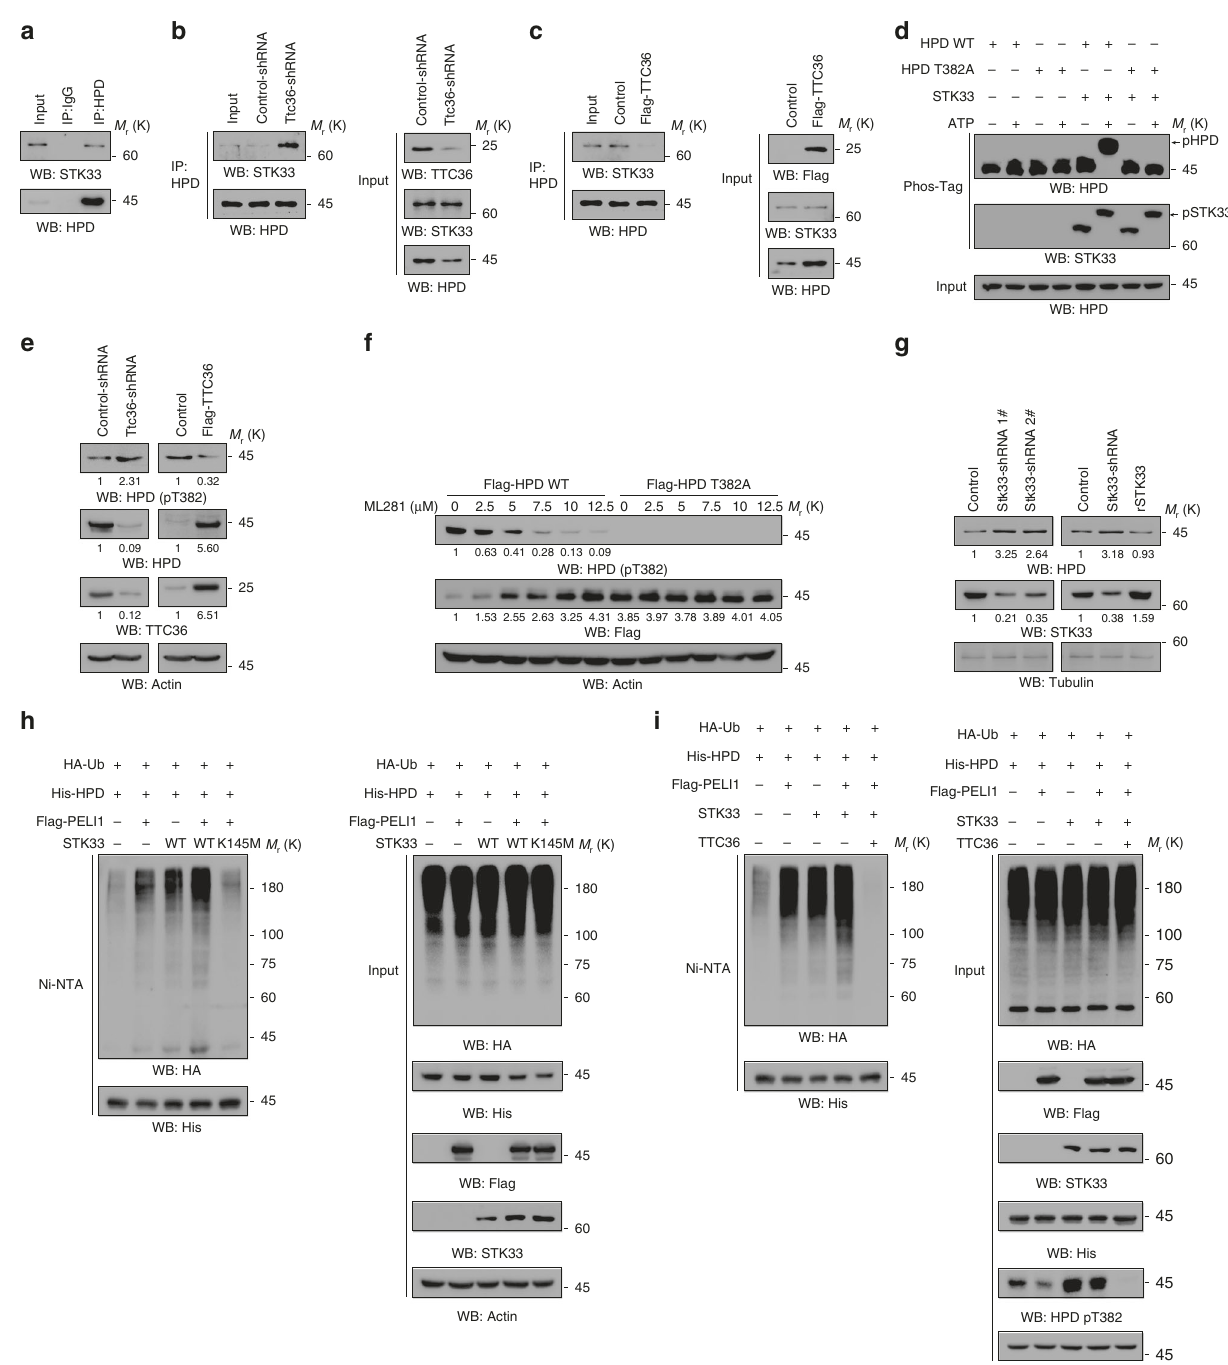
Fig. 4 TTC36 reduces the binding of STK33 to HPD and subsequent STK33-mediated HPD T382 phosphorylation. Immunoblotting analyses were performed with the indicated antibodies a – i . a Immunoprecipitation analyses of LO2 cell lysates were performed with an anti-HPD antibody. b , c Ttc36 shRNA b or Flag-TTC36 c were stably expressed in LO2 cells. Immunoprecipitation analyses with an anti-HPD antibody were performed. d Phos-tag analysis was performed with bacterially puri fi ed His-STK33 and His-HPD or His-HPD T382A mutant in the presence or absence of ATP. e Ttc36 shRNA#1 (left panel) or Flag-TTC36 (right panel) were stably expressed in LO2 cells. The quanti fi cation numbers represent relative intensity of presented bands. f LO2 cells expressing Flag-HPD or Flag-HPD T382A mutant were treated with the indicated dosages of ML281 for 48h. The quanti fi cation numbers represent relative intensity of presented bands. g LO2 cells expressing Stk33 shRNA#1 or #2 (left panel) with or without reconstituted expression of RNA-resistant(r) STK33 (right panel) were examined by immunoblotting analyses with the indicated antibodies. The quanti fi cation numbers represent relative intensity of presented bands. h , i HEK293T cells were transfected with the indicated plasmids. MG-132 (10 μ M) was added 12h before they were harvested with a guanidine – HCl- containing buffer. A Ni-NTA pull-down assay was